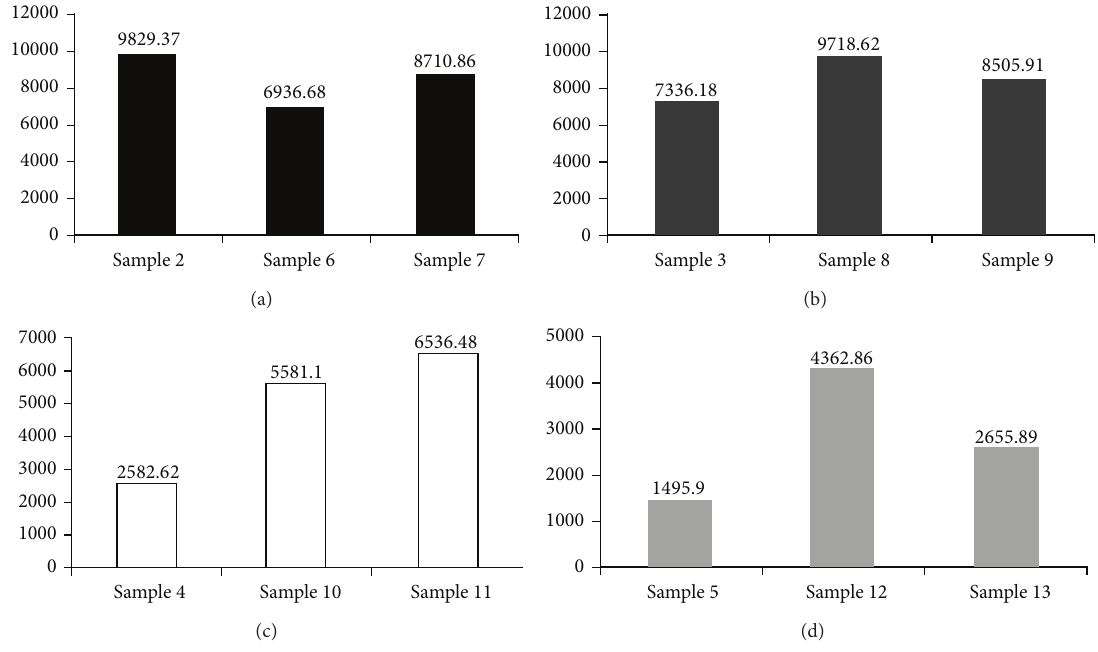
Figure 5: Distribution of elasticity modulus (Kilo Pascal) for samples.